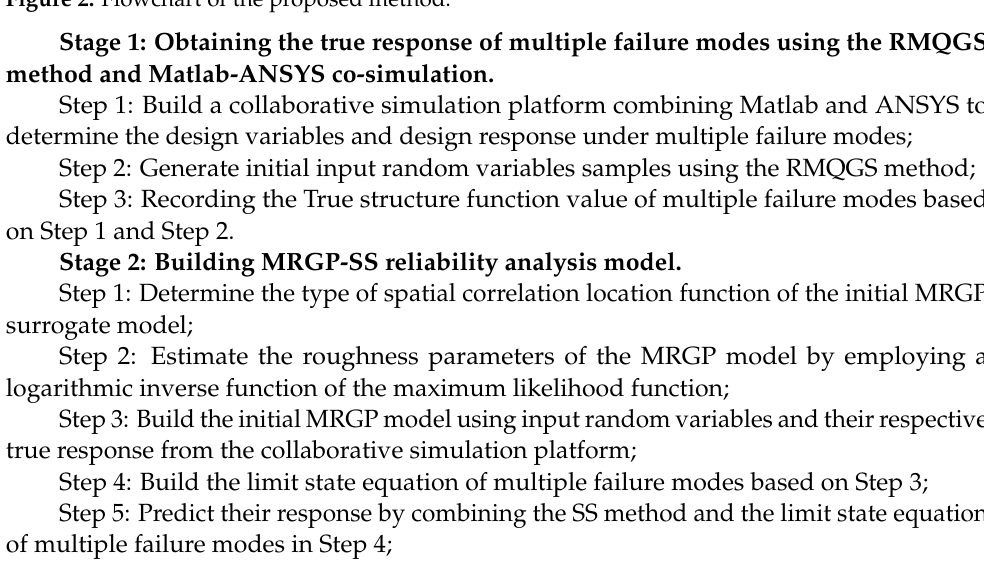
Figure 2. Flowchart of the proposed method.